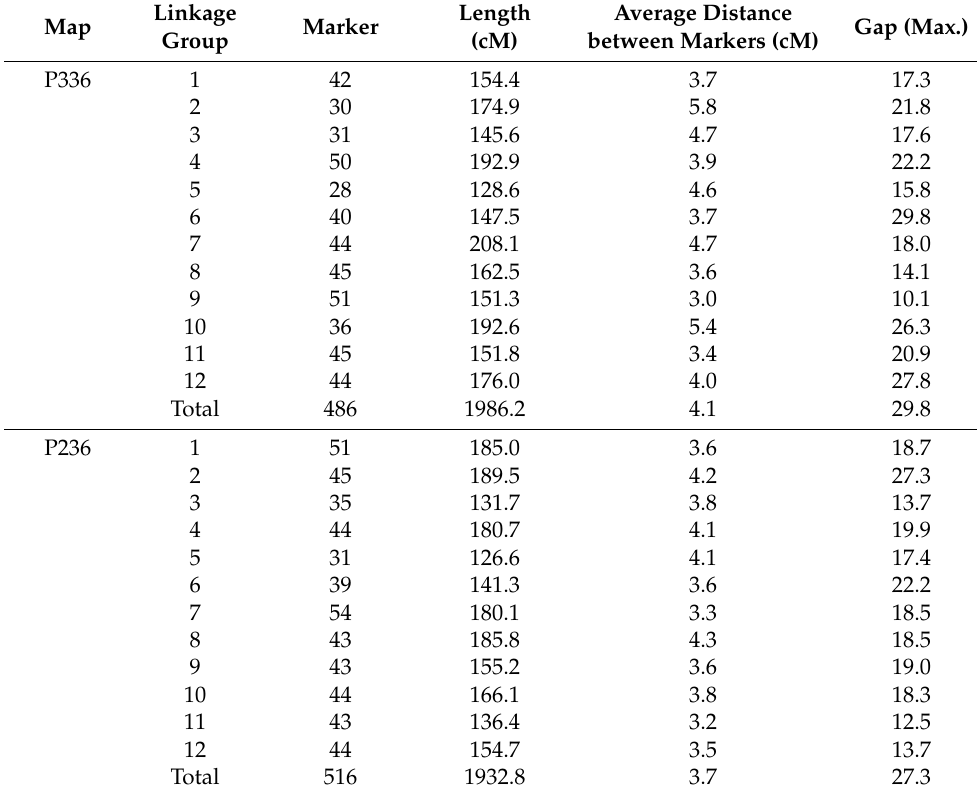
Figure 2. The relationships between functional traits based on network analysis. D16: Stem diameter in 2016, H16: Height in 2016, H17: Height in 2017, CR17: Crown area in 2017, Bud_fl: Bud flush in 2016, Freez_tol: Freezing tolerance in Nov 2016, Lw_ratio: Needle length/width ratio, LMA: Leaf mass per area, Bark_xy: Bark-xylem length ratio, Norm_reac: Normal/reaction wood ratio, SD: Stoma density, SRN: Number of stoma row, Φ II : Effective quantum yield of PSII, NPQ: Non-photochemical quenching, Φ NO : Non-regulated energy dissipation at PSII centers. Table 3. The length of and the number of markers in each linkage